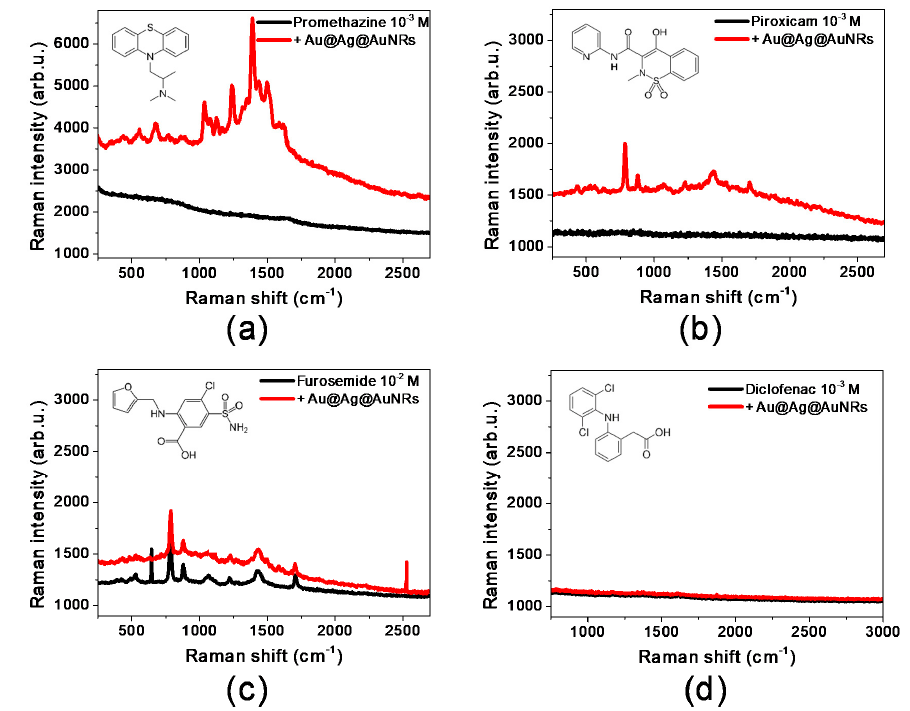
Figure 3. SERS enhancement of selected drug active ingredients in the presence of Au@Ag@AuNRs: ( a ) promethazine (10 − 3 M in aqueous solution); ( b ) piroxicam (10 − 3 M in ethanol solution); ( c ) furosemide (10 − 2 M in ethanol solution); ( d ) diclofenac (10 − 3 M in aqueous solution). Molecular structures of the active ingredients are reported as insets in the respective graphs. Table 3. Raman shift and intensity of reference signals for promethazine, piroxicam, furosemide and